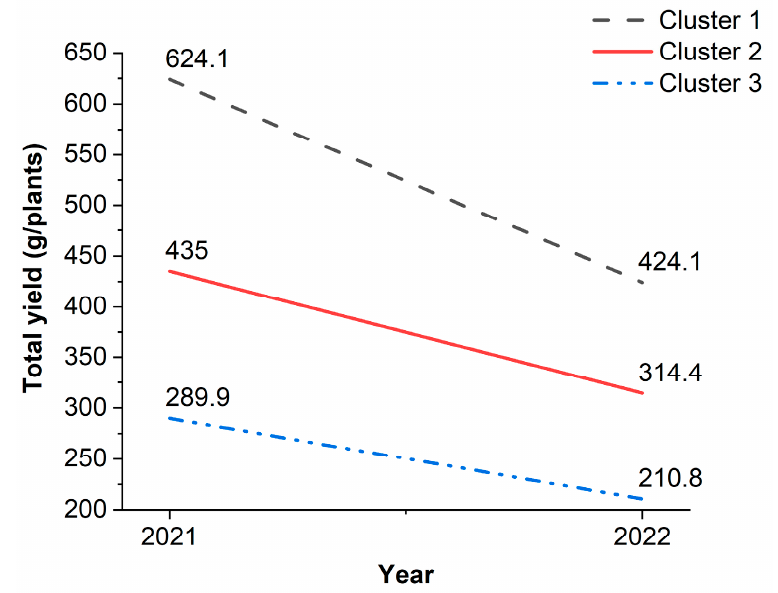
Figure 2. Grouping cultivars of strawberry by yield by the K-mean cluster analysis.